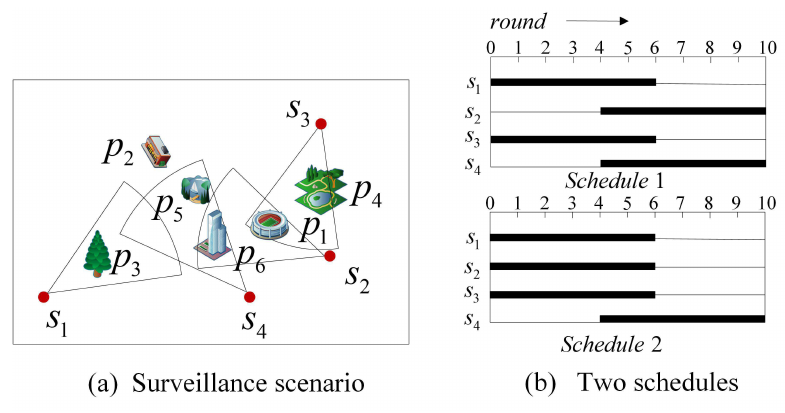
Figure 1. A surveillance scenario in a virtual sensor network